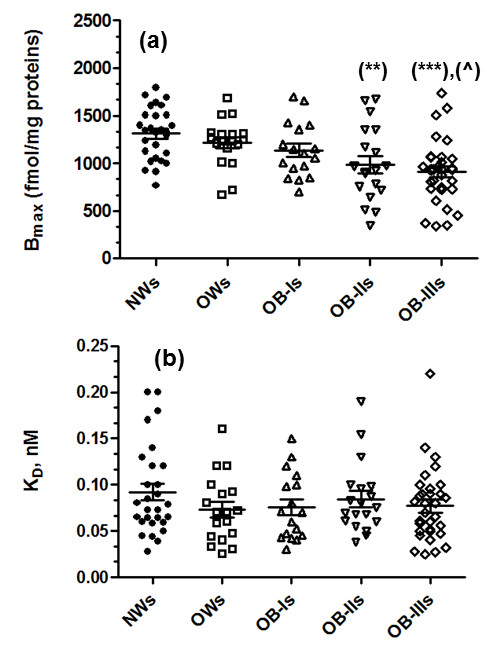
SERT parameters and ANOVA analysis. Scattergram plots of a) [3H]-paroxetine Bmax, fmol/mg protein (SERT number) and b) [3H]-paroxetine KD, nM (SERT affinity), obtained in platelets from individuals of the 5 BMI (Kg/m2) groups. Among group ANOVA: p < 0.0001 (all groups); Bonferroni post-hoc tests showed significant tests: (**): OB-IIs vs. NWs; (***): OB-IIIs vs. NWs and (^): OB-III vs. OWs. Each scattergram plot also shows the mean ± SEM.